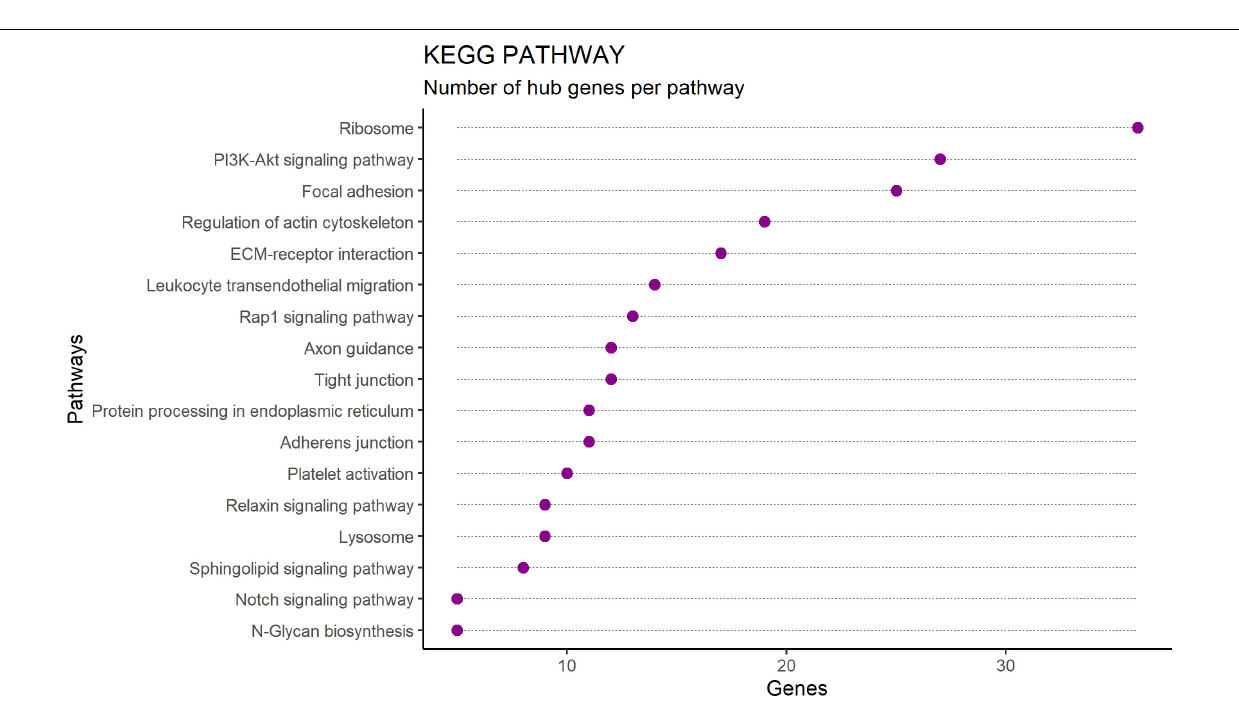
hub genes reported here were previously associated with feed efficiency-related traits as QTLs (de Oliveira et al., 2014), as DE genes in contrasting RFI groups (Tizioto et al., 2016), as described for bovine (de Souza et al.,